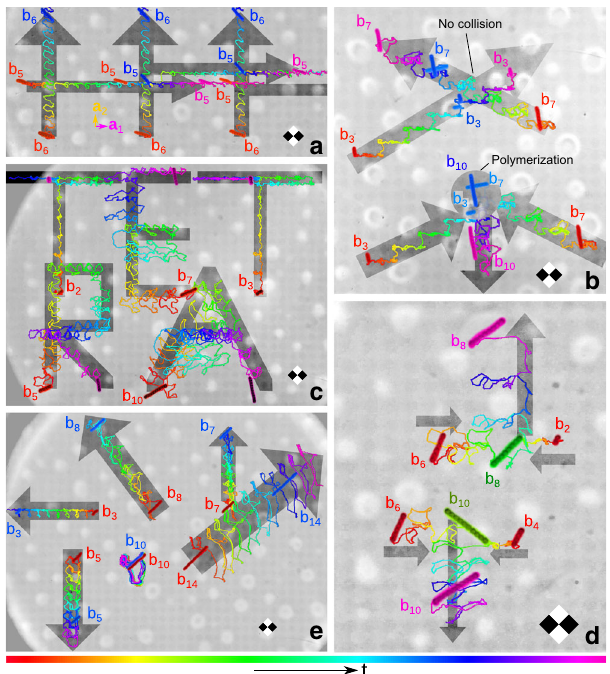
Fig. 2 Experimental trajectories of bipeds driven by parallel polydirectional loops. a parallel didirectional loop of robustness ρ = 0.16 and compaction c = 1/2 transporting several bipeds b 5 into the a 1 -direction and bipeds b 6 into the a 2 -direction. b parallel tridirectional loop of robustness ρ = 0.3 and compaction c = 7/8 setting two bipeds b 3 and two bipeds b 7 on a collision course. One pair of bipeds collides and polymerizes to a longer biped b 10 that is then transported into a third direction. The non- colliding bipeds continue their motion. c Parallel tetradirectional loop of robustness ρ = 0.2 and compaction c = 30/54 commanding bipeds of fi ve different lengths { b 3 , b 7 , b 2 , b 5 , b 10 } to simultaneously write four different letters. The biped b 2 is topologically equivalent to the biped b 3 and hence writes the same letter (T). d Parallel pentadirectional loop of robustness ρ = 0.11 and compaction c = 5/6 commanding a biped b b 2 and a biped 4 to polymerize with two colliding bipeds b 6 and then separate as they form a biped b 8 and a biped b 10 . e Parallel hexadirectional loop of robustness ρ = 0.06 and compaction c = 4/8 transporting six bipeds of different lengths into six different directions. The color of both bipeds and trajectories indicates the time progress of one control loop (see bottom colorbar). A square region of the pattern of diagonal 2 a ≈ 22 μ m is sketched in each panel to indicate the scale and the relative orientation.